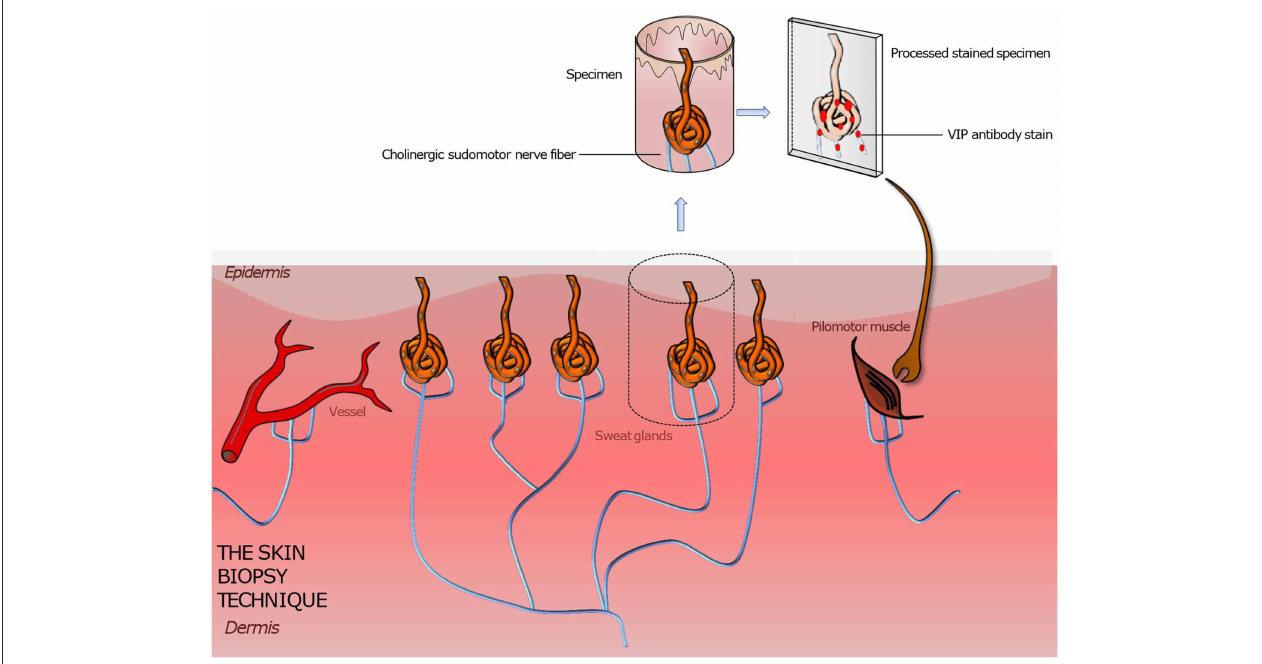
FIGURE 3 | Illustration of a punch skin biopsy on eccrine sweat glands to quantify the cholinergic sudomotor nerve fibers. The specimen is fixed, sectioned, and stained with antibodies for PGP 9,5 (the pan axonal marker), tyrosine hydroxylase (a sweat gland neuroendocrine cell marker), and VIP (a marker for sympathetic nerve fibers) to highlight the sought-after tissue. Further various quantitation methods are applied to assess the sweat gland nerve fiber density. Based on this technique pilomotor and vasomotor autonomic nerve fibers can be quantified by using suitable staining methods. A comparison of the determined nerve fiber density to those of normative datasets gives information about the functionality and condition of the autonomic nervous system innervating skin organs.